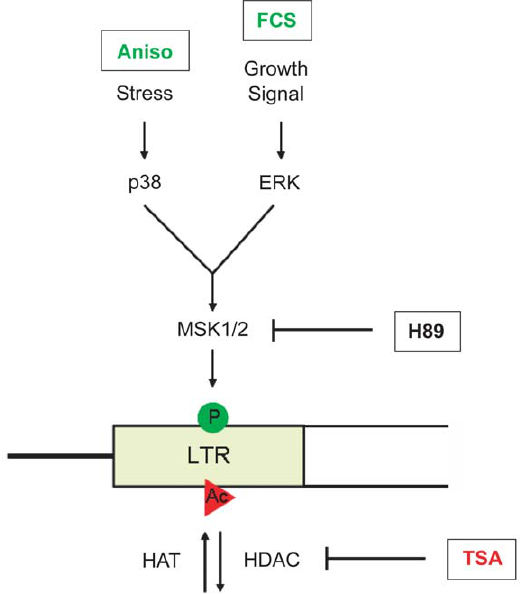
Figure 6. Inhibition of H3S10 phosphorylation with the protein kinase inhibitor H89 precludes transcriptional activation of VL30 elements. (A) Treatment of arrested Swiss 3T3 fibroblasts with the protein kinase inhibitor H89 (10 m M), inhibiting H3S10 phosphory- lation, prohibits the creation of a phosphoacetylation mark upon 1h of Aniso + TSA treatment. ChiP experiments were performed as in Figure 5C. (B) Precluding phosphoacetylation of VL30 elements with H89 also abolishes transcriptional induction upon Aniso + TSA treatment. Treatments as in (A); quantification of VL30 transcript levels were determined as in Figure 5E. N=3; 6 SD *p , 0.05.